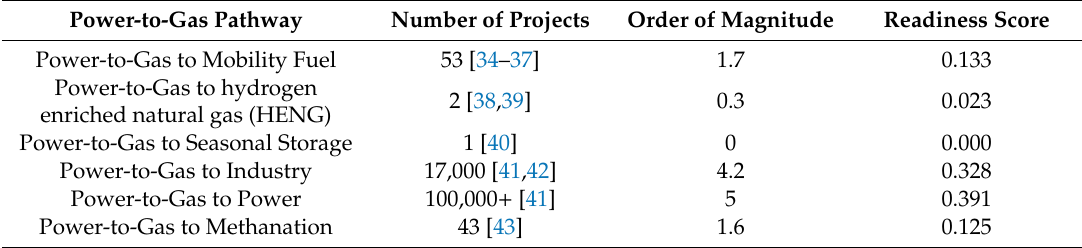
Table 5. Number of power-to-gas Projects per Pathway—Readiness